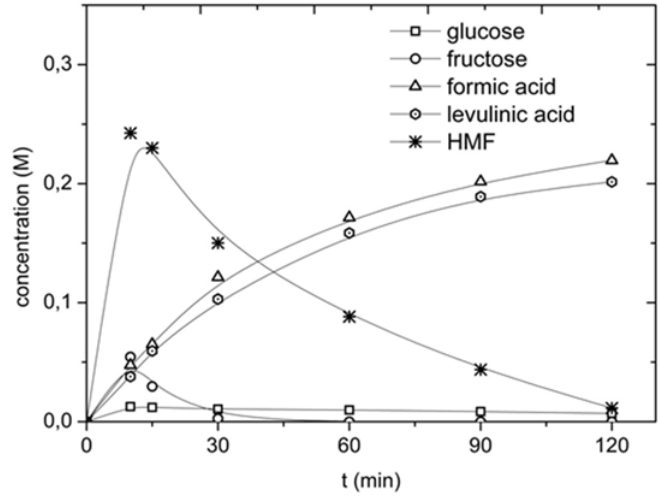
Figure 4. Concentration versus time profile for the reaction of inulin using CuCl 2 (T = 180°C, C Cu(II) = 0.01 M, C inulin = 0.1 g/mL).